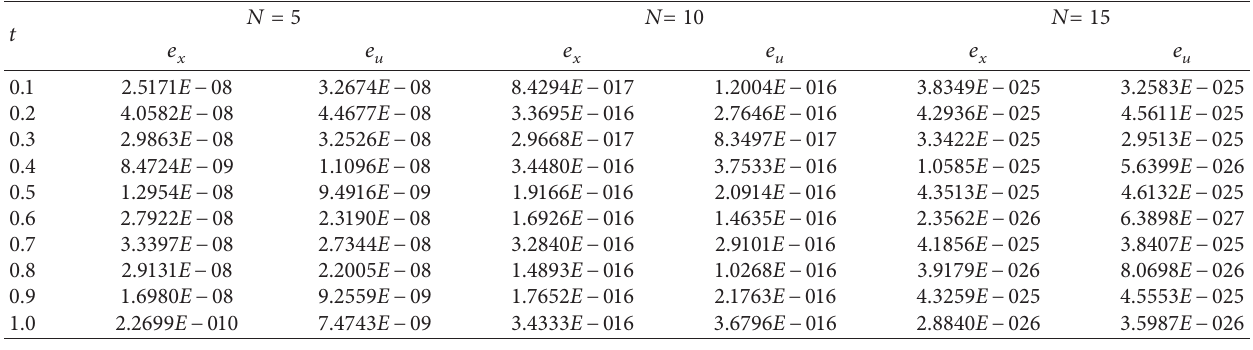
Figure 1: Approximate solutions of x ( . ) and u ( . ) with N � 10 in Example 1. (a) Approximate solution of x ( . ) . (b) Approximate solution of u ( . ) . Table 1: Absolute errors of x ( . ) and u ( . ) with different values of N in Example 1.